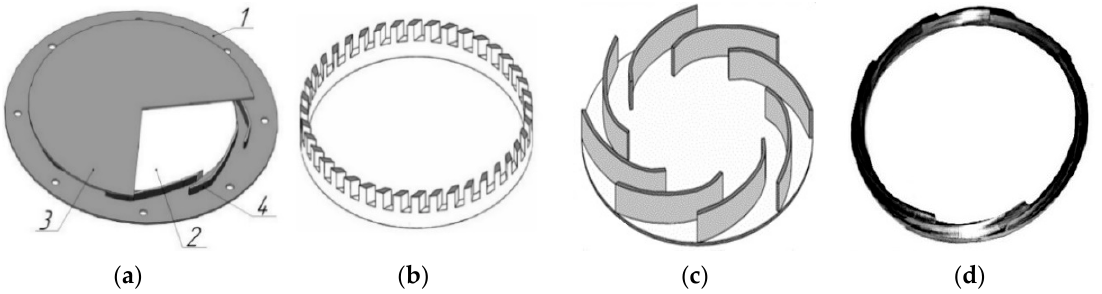
Figure 1. Swirler structure. ( a ) Channels, ( b – d ): 1—tray deck; 2—steam channel; 3—cover; 4—tangential swirler.